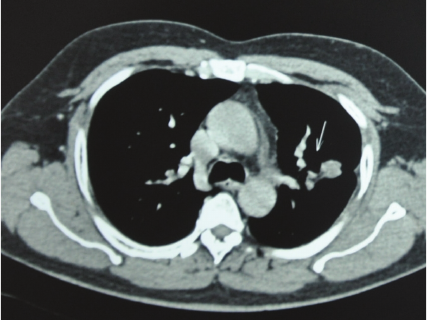
Figure 4: After 4 cycles of chemotherapy CT scan of the lung (transverse section) showing reduction in the size of the lung lesion; measuring 3.0 ∗ 2.1 cms in the left upper